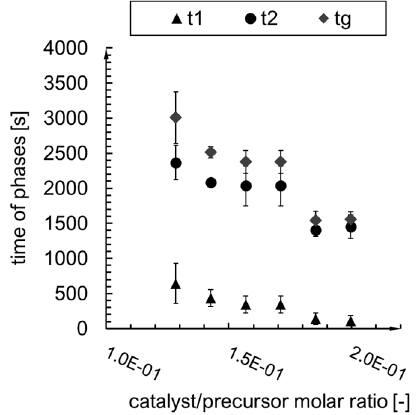
Figure 7. Condensation kinetics curves of A–F syntheses.